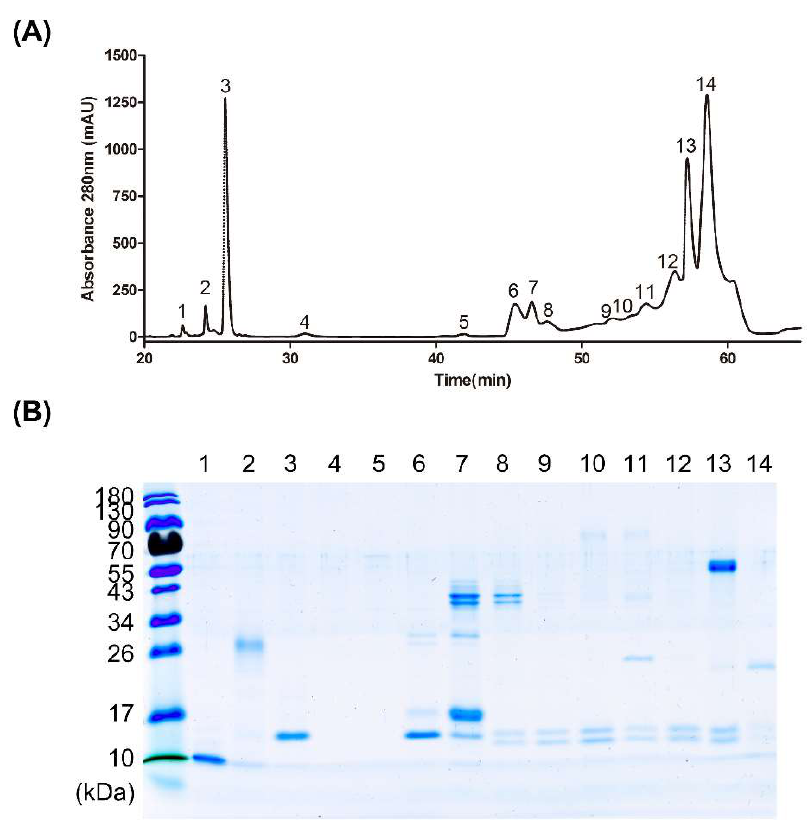
Figure 2. Protein profile of HPLC-separated D. acutus venom. ( A ) Crude venom was fractionated via RP-HPLC and 14 fractions were collected from the peak signals at an absorbance of 280 nm. ( B ) Fractionated proteins from D. acutus venom were analyzed via SDS-PAGE and visualized with Coomassie blue staining. The intensity of bands indicates relative abundance of proteins.